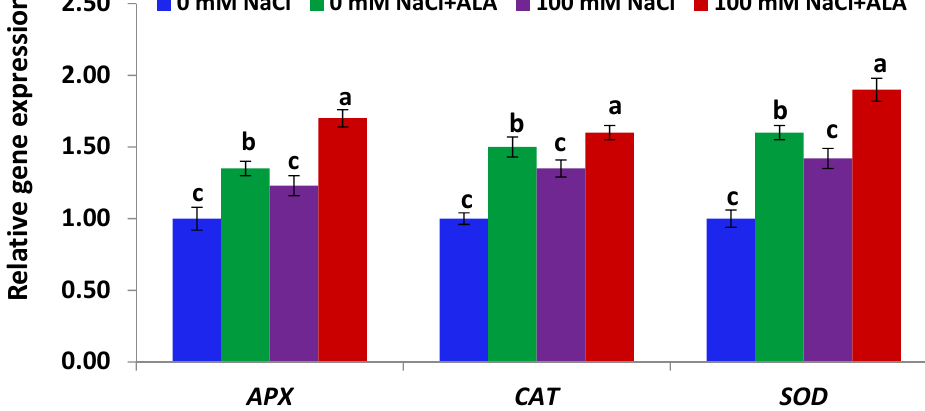
Figure 6. Expression level of antioxidant genes in Carmen cultivar leaves under salt and/or ALA (7 ppm) effects. Values represent means ± SE ( n = 4). Different letters show significant difference among treatments ( p ≤ 0.05).